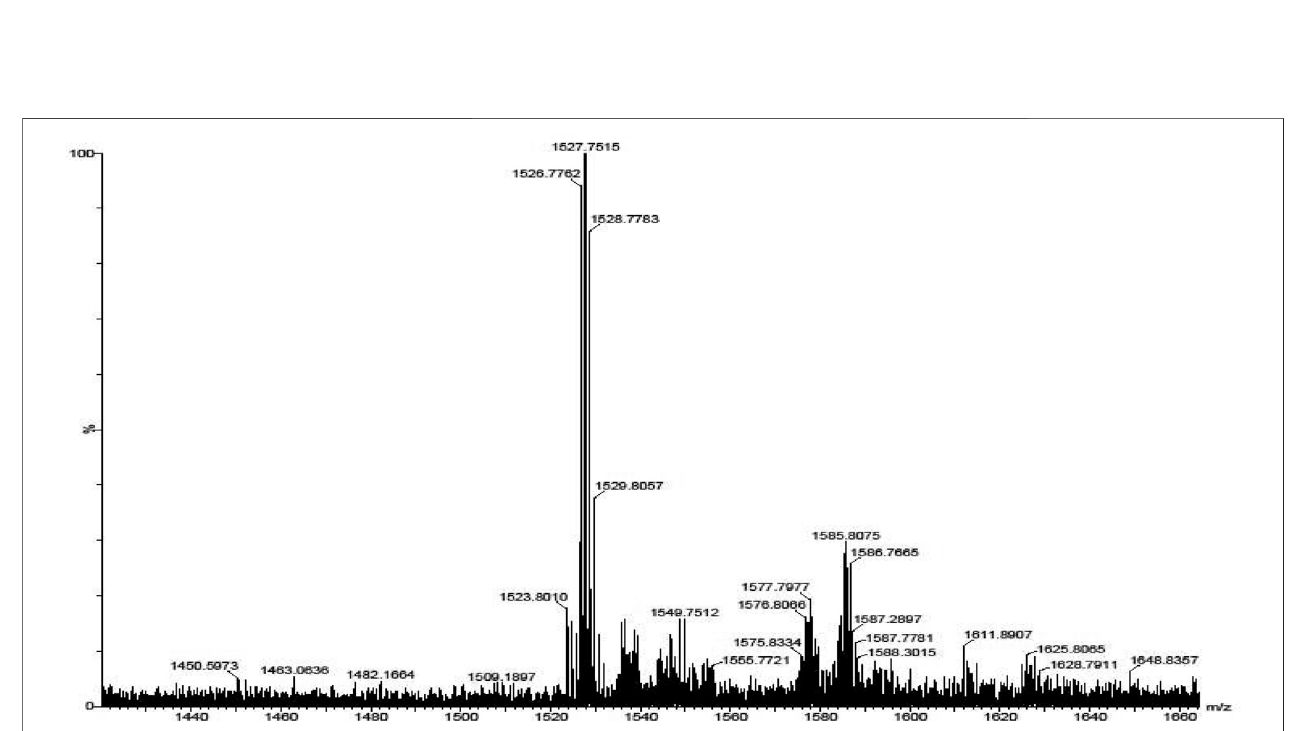
FIGURE 7 | Mass spectrum for phthalocyanine IXc with mass fragment (M . ) (cid:2) 1526; (M+1) (cid:2) 1527; and (M+3) (cid:2) 1529.